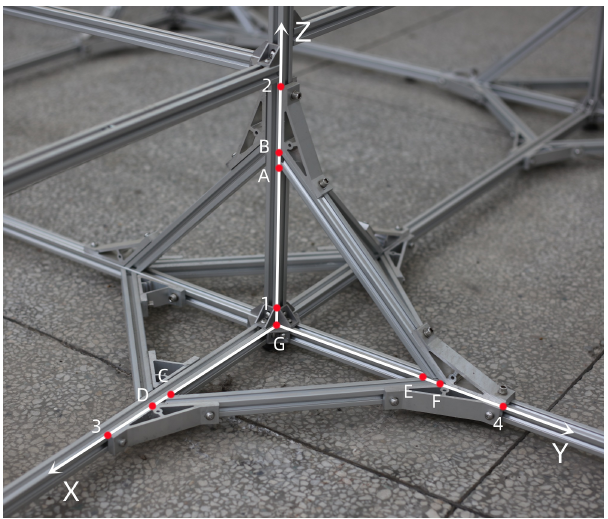
Figure 8. Points selection of second